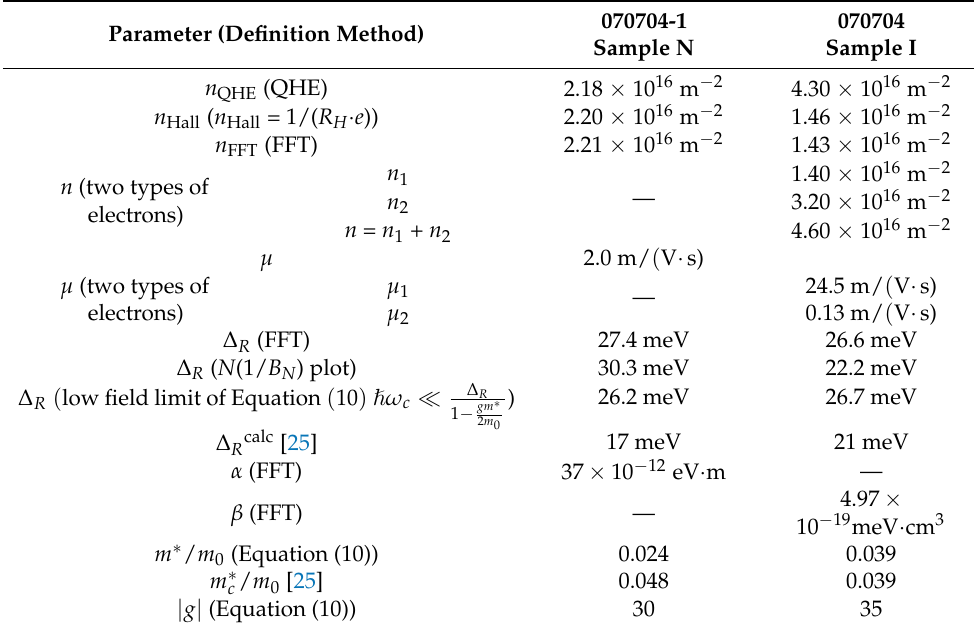
Table 2. Electron gas and Rashba spin-orbit parameters of the samples under